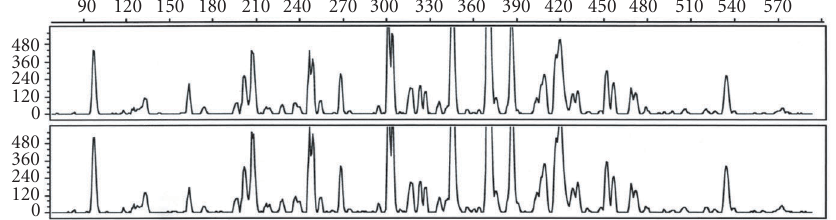
Figure 4. Fluorescent detection of RAF profiles. The oligonucleotide primer K-06 (5 (cid:3) -CACCTTTCCC-3 (cid:3) ) was synthesized and tagged with FAM (6-carboxy- fluorescein), and then used in the RAF protocol with genomic DNA from sugarcane hybrid Q117. After the PCR, the RAF profiles were separated and detected on an Applied Biosystem 373A DNA sequencer. The two panels represent RAF profiles amplified from replicate DNA extractions. The size of RAF markers (in bp) is shown on the X axis, and the relative intensity of the signals is shown on the Y axis. Larger RAF fragments were also amplified but these are not shown.